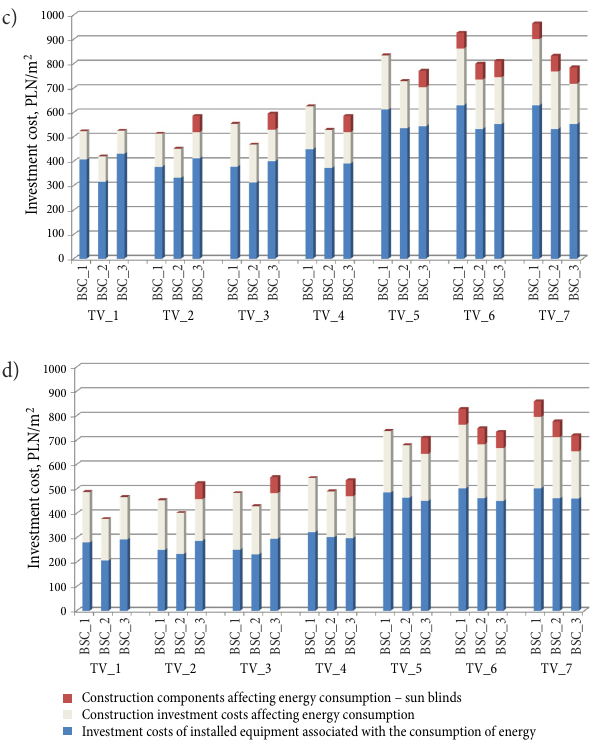
Fig. 2. The investment unit costs of the installed equipment related of the usage of the energy for the analysed buildings and the applied heat sources, PLN/m 2 : a – GCB; b – DH; c – GHP; d –